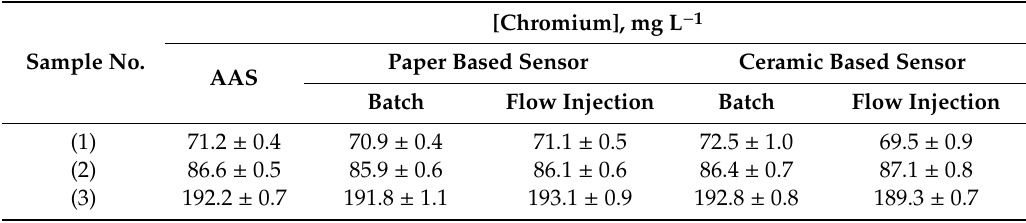
Table 2. Potentiometric determination of chromium in some leather tanning wastewater samples using paper and ceramic based chromium (VI) sensors with PANI solid contact.